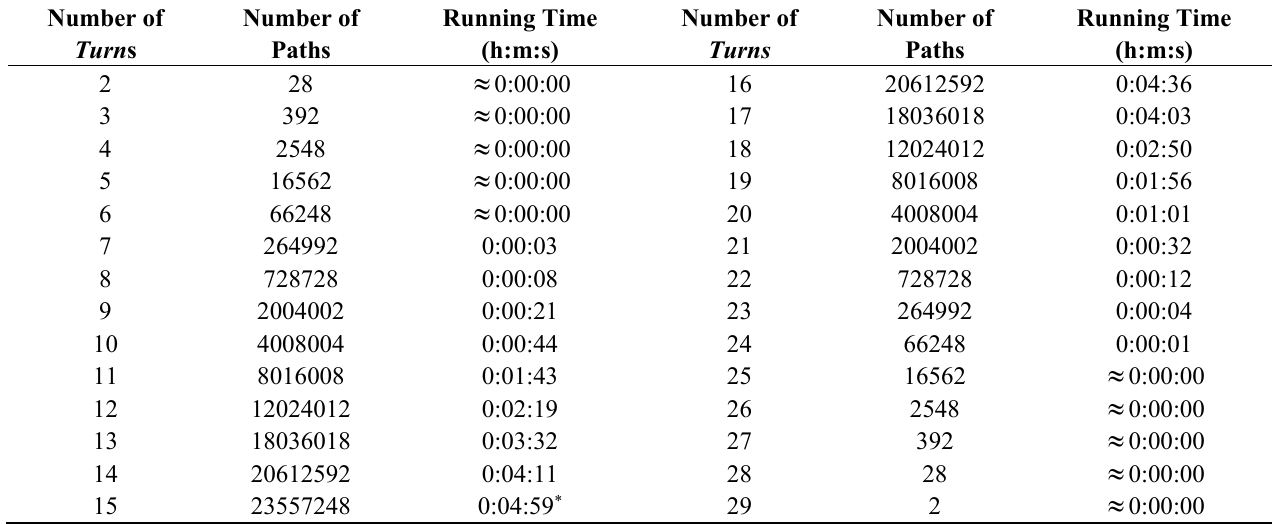
Table 4. Running Time of G2DLP for 2D lattice L (15, 15).